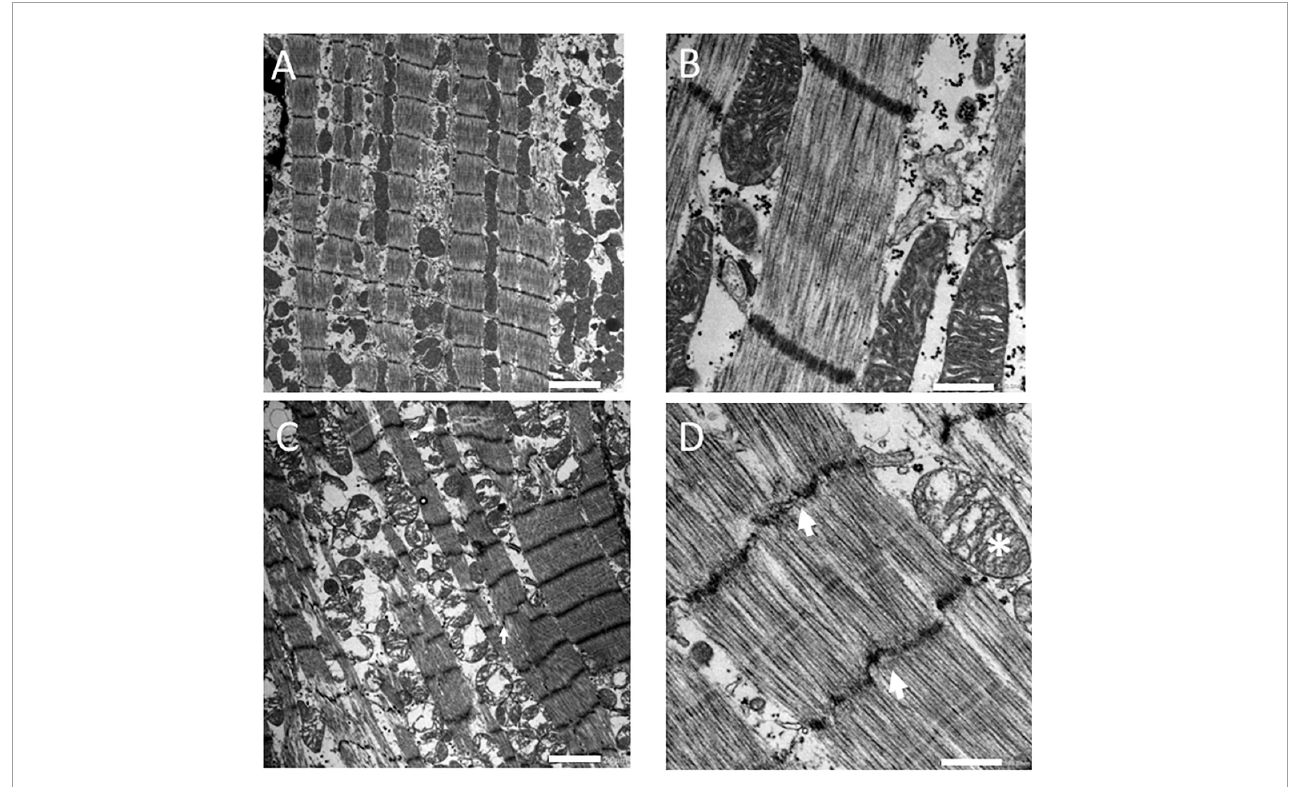
FIGURE2 Electron microscopy images of fresh control (A,B) and stone heart (C,D) samples. Scale bar: 2 µ m (A,C) , 0.5 µ m (B,D) . Arrows indicate Z-line streaming, asterisk indicates a swollen mitochondrion. Electron microscopy was performed on two animals in each